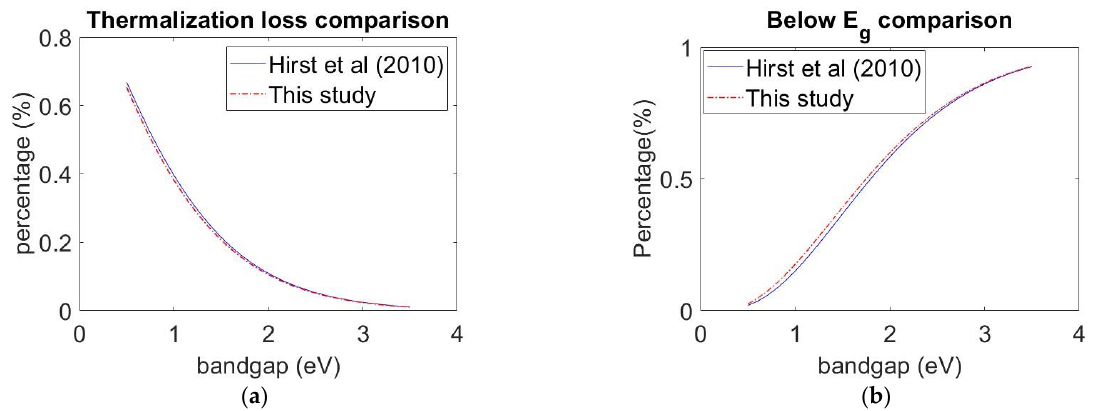
Figure 4. Comparison of loss due to ( a ) Thermalization and ( b ) Below 𝐸 𝑔 between this study and Hirst et al. (2010) [60]. Table 1. Maximum absolute error in loss calculations and their corresponding bandgap values.